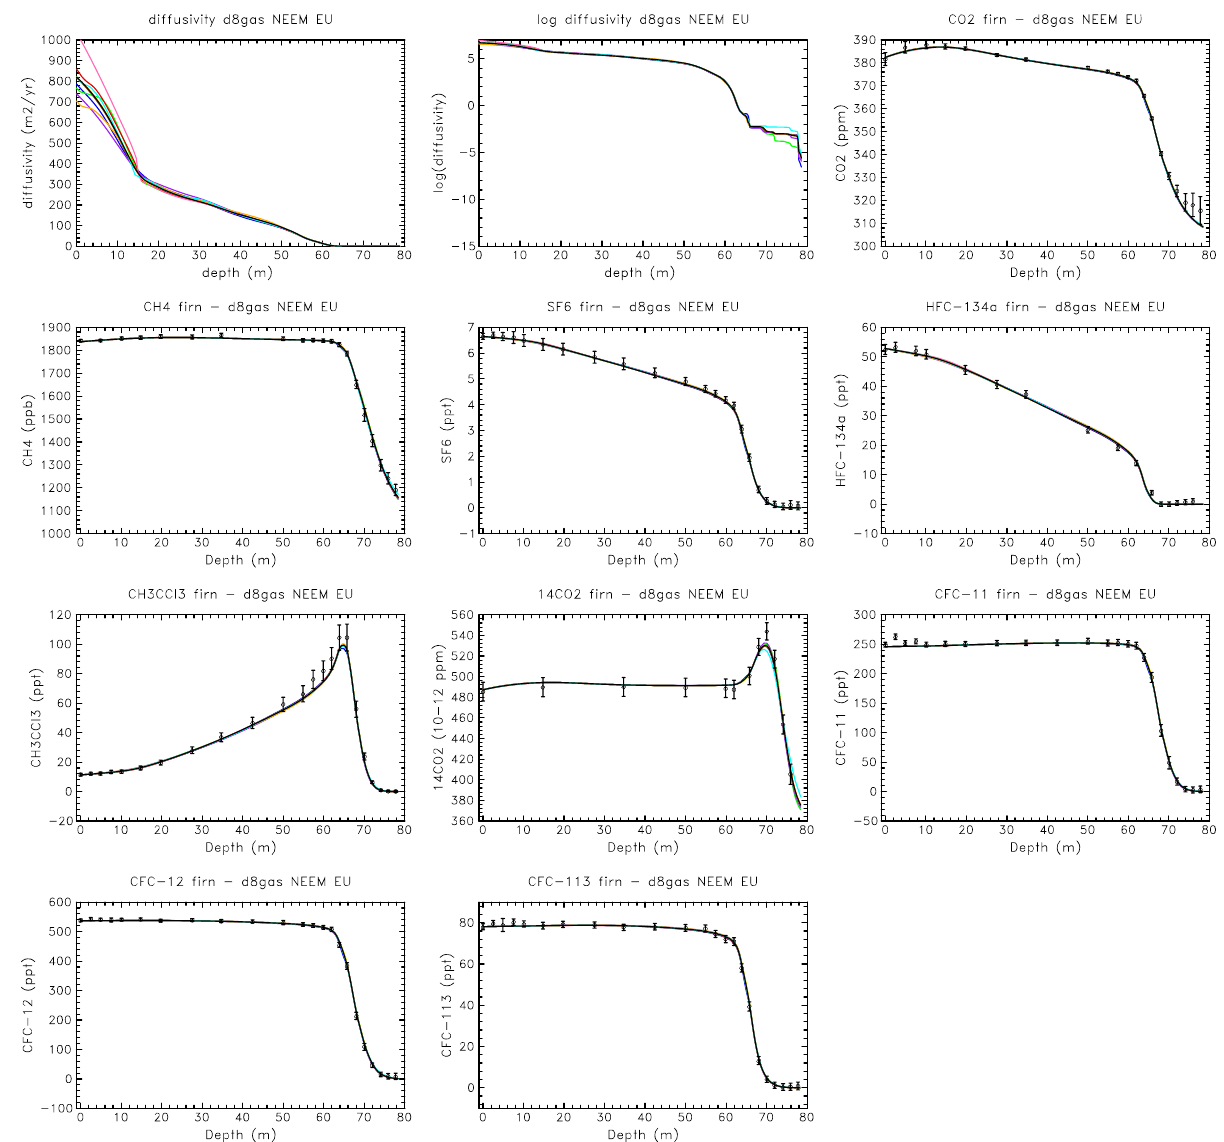
Fig. 6. Multiple gases inverse diffusivity model for NEEM (EU hole): the diffusivities (reduced to CO 2 ) are computed with 8 reference gases out of 9 (one gas removed for each test). The removed gases are CO 2 (blue), CH 4 (green), SF 6 (red), HFC-134a (orange), CH 3 CCl 3 (violet), 14 CO 2 (turquoise), CFC-11 (pink), CFC-12 (yellow), CFC-113 (brown) and none (black,